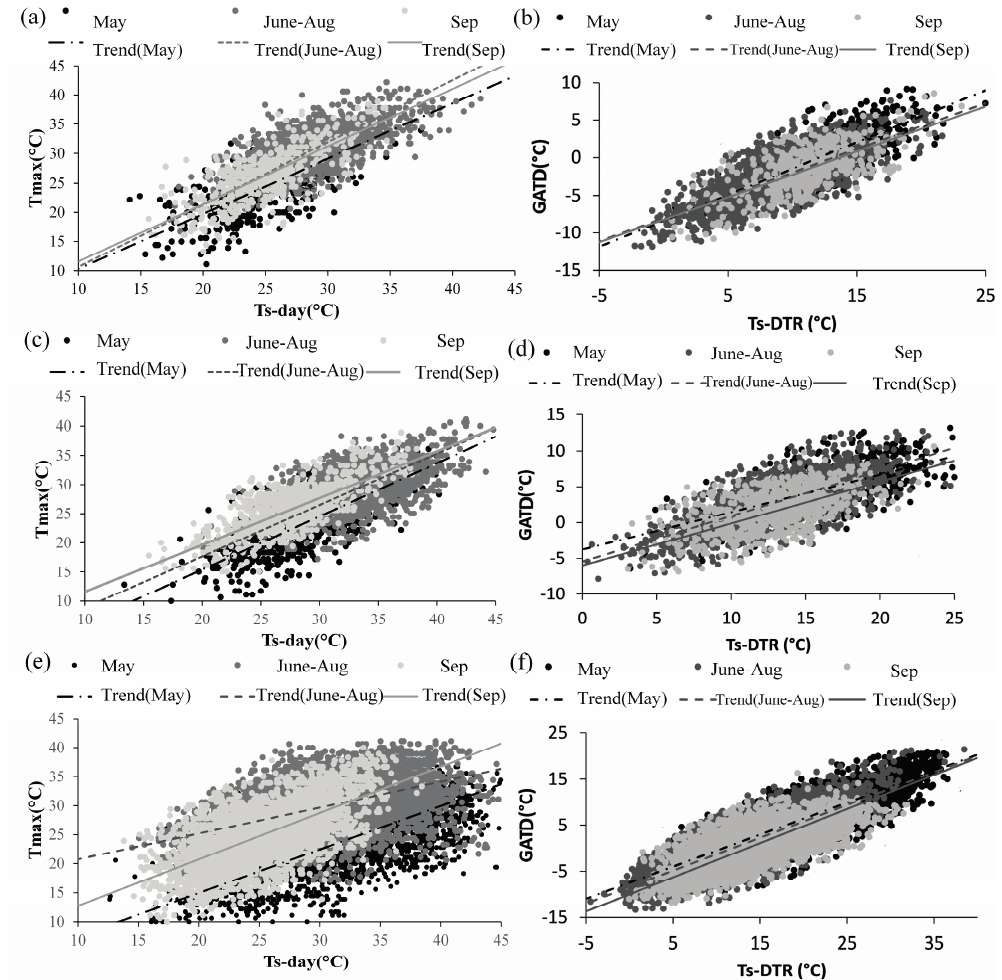
Figure 5. Scatterplot of Ts-day vs. Tmax (°C) and GATD vs. Ts-DTR (°C) for: ( a , b ) forest; ( c , d ) developed; and ( e , f ) crops areas across the entire study area from 2008 to